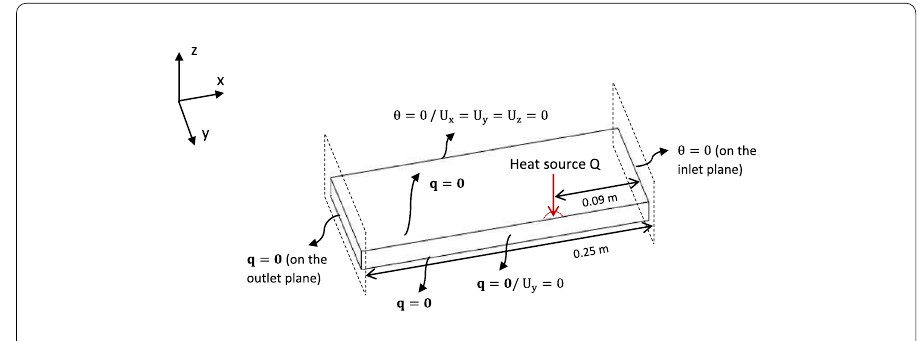
Fig. 7 Control volume with boundary